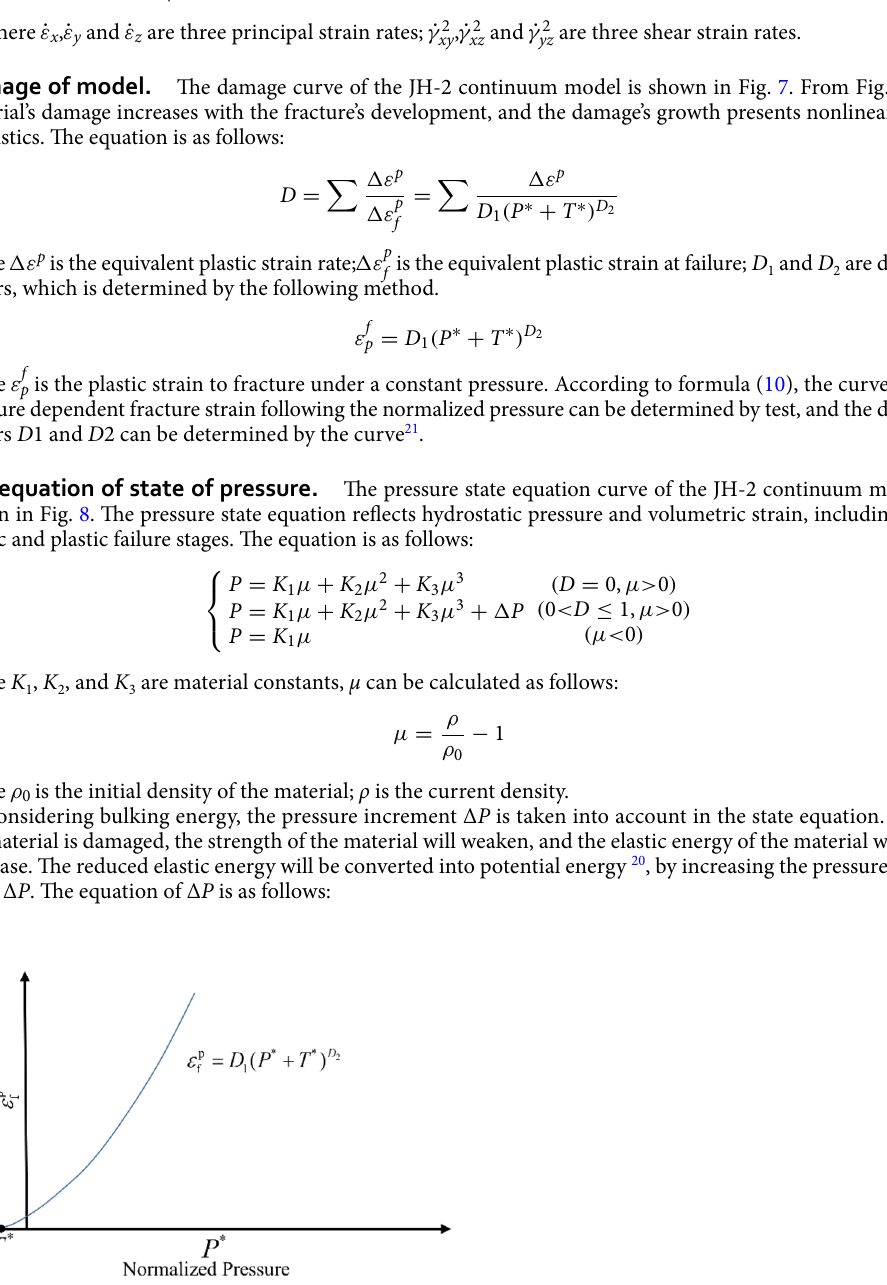
Figure 7. Damage model of the JH-2 constitutive